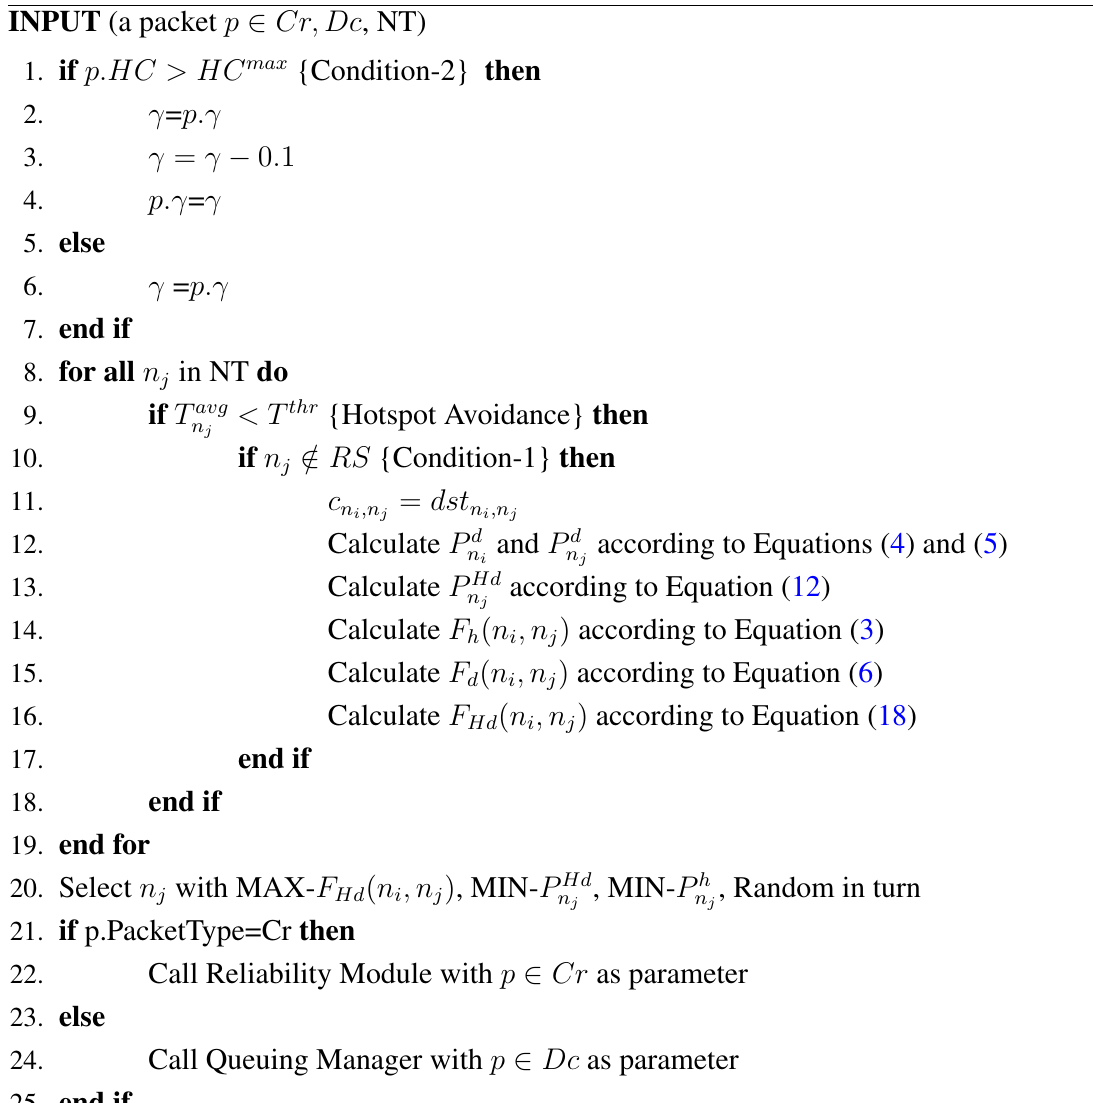
Algorithm 1 Route selection algorithm at delay